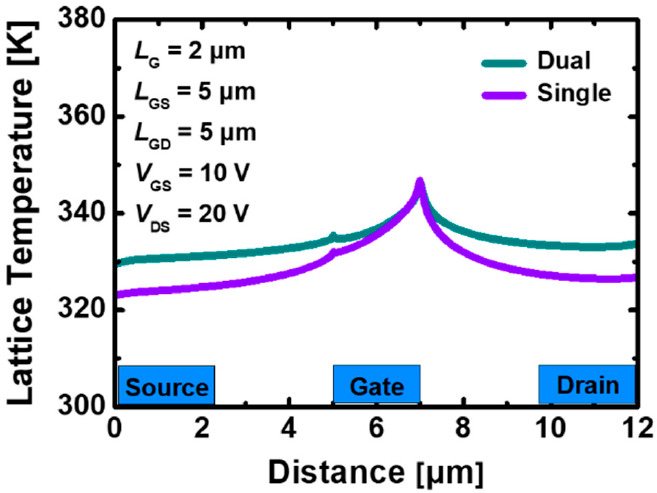
Figure 10. Lattice temperature distribution across the 2DEG channel layer with self-heating effect in recessed-gate GaN MOSFET using the stacked TiO 2 /Si 3 N 4 dual-layer insulator and Si 3 N 4 single-layer insulator on SiC substrate under bias V GS = 10 V, V DS = 20 V.